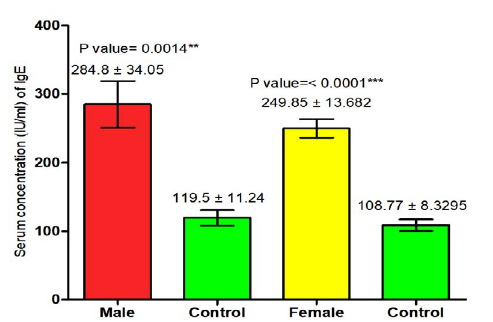
Fig. 4. Comparison between serum level of IgE in total patients and total control